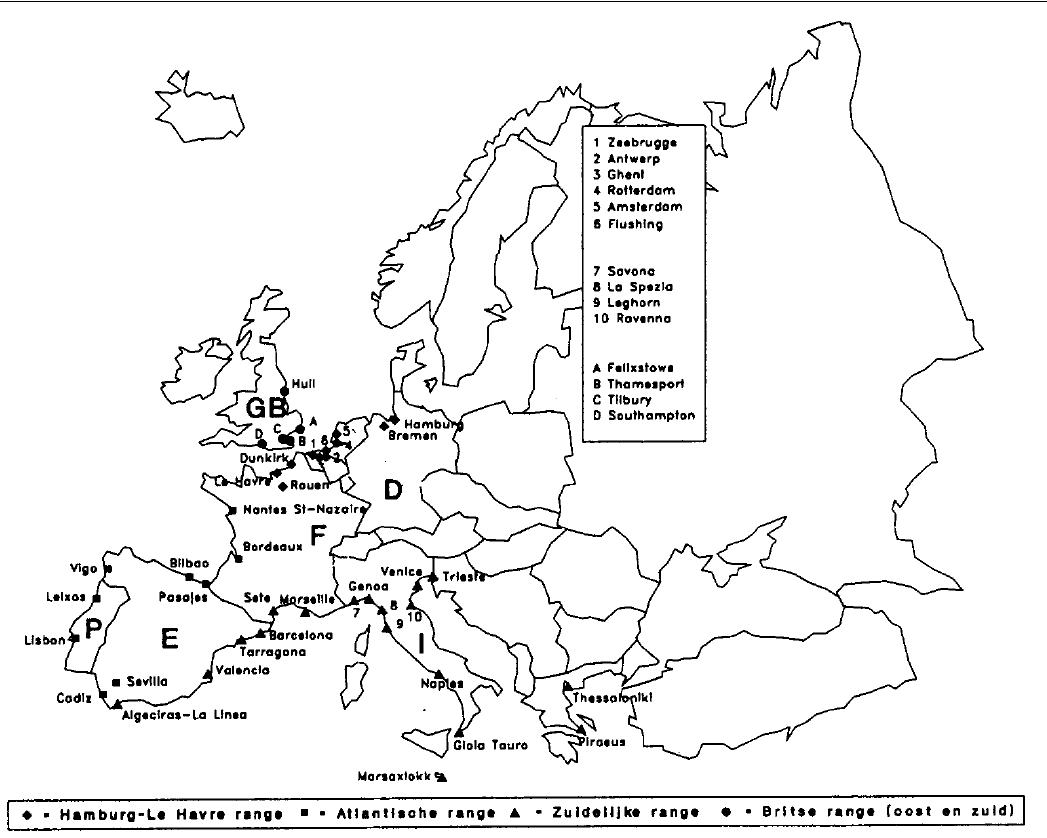
Figure 2. Location of the European container ports The emphasis is on the Hamburg - Le Havre range (11 ports), the Atlantic range (9 ports), the southern European range (18 ports on the Mediterranean Sea) and a limited British range (5 ports on the Eastern and Southern coasts of the United Kingdom). The ports along the Baltic Sea have been omitted, as have the Scandinavian ports. Total container transfer within the European port system under consideration amounted to 27.4 million TEU in 1996, compared with 4.3 million TEU in 1975. The Hamburg - Le Havre range accounted for 14.1 million TEU in 1996, more than half the total transferred (Notteboom & Winkelmans, 1998: